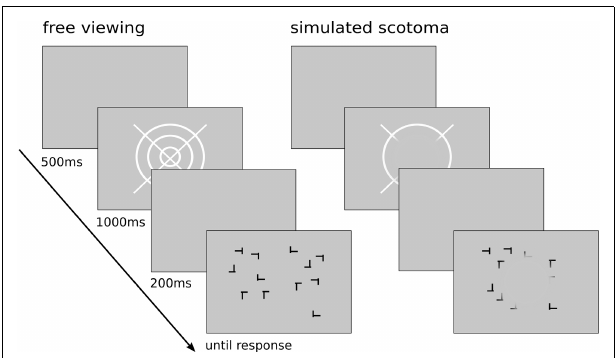
FIGURE 1 | Schematic diagram of an experimental trial. A trial consisted of the presentation of a blank screen (500 ms), a fixation target (1000 ms), another blank screen (200 ms), and the search display (presented until response). Left: A trial in the unimpaired condition. Right:Visualization of the display layout with the simulated scotoma covering parts of the screen. The scotoma had a diameter of 9 ◦ smoothly fading out at the edges.The fully opaque area of the scotoma measured 7 ◦ in diameter which appeared invisible to the participant while the visibility of the stimulus display gradually increased at the edge of the opaque